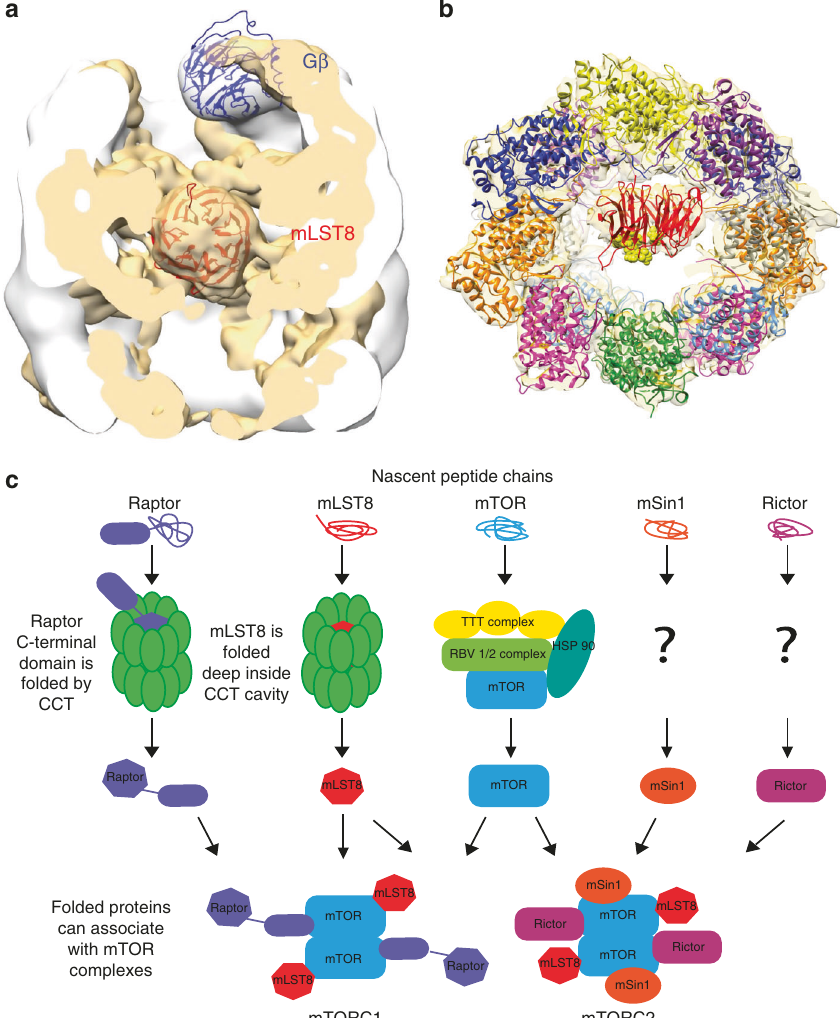
Fig. 7 The role of CCT in the folding of β -propeller proteins. a Differences in the β -propeller location in the CCT cavity. The 3D reconstructions of G β – CCT (white) 18 and mLST8 – CCT (tan) reveal the different location of the two β -propellers. b Position of the mTOR binding site on mLST8 in the mLST8 – CCT complex. Residues on mLST8 that bind mTOR are shown as yellow spheres. c Hypothetical scheme of the chaperones involved in assembly of mTOR complexes, highlighting CCT-dependent folding of mLST8 and